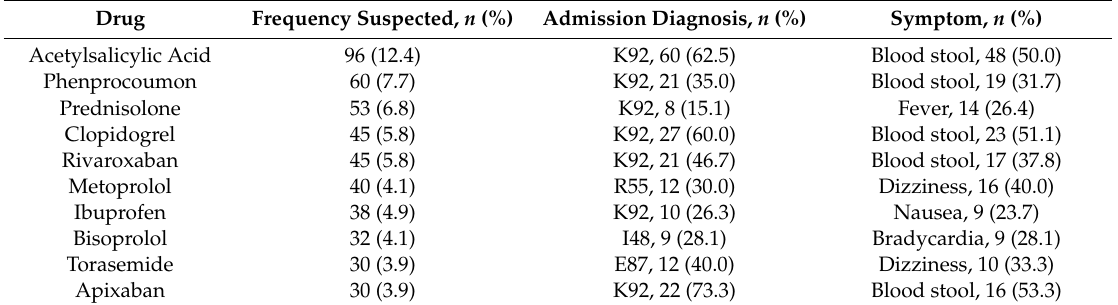
Table 2. Frequent admission diagnoses and symptoms per patients with suspected substance